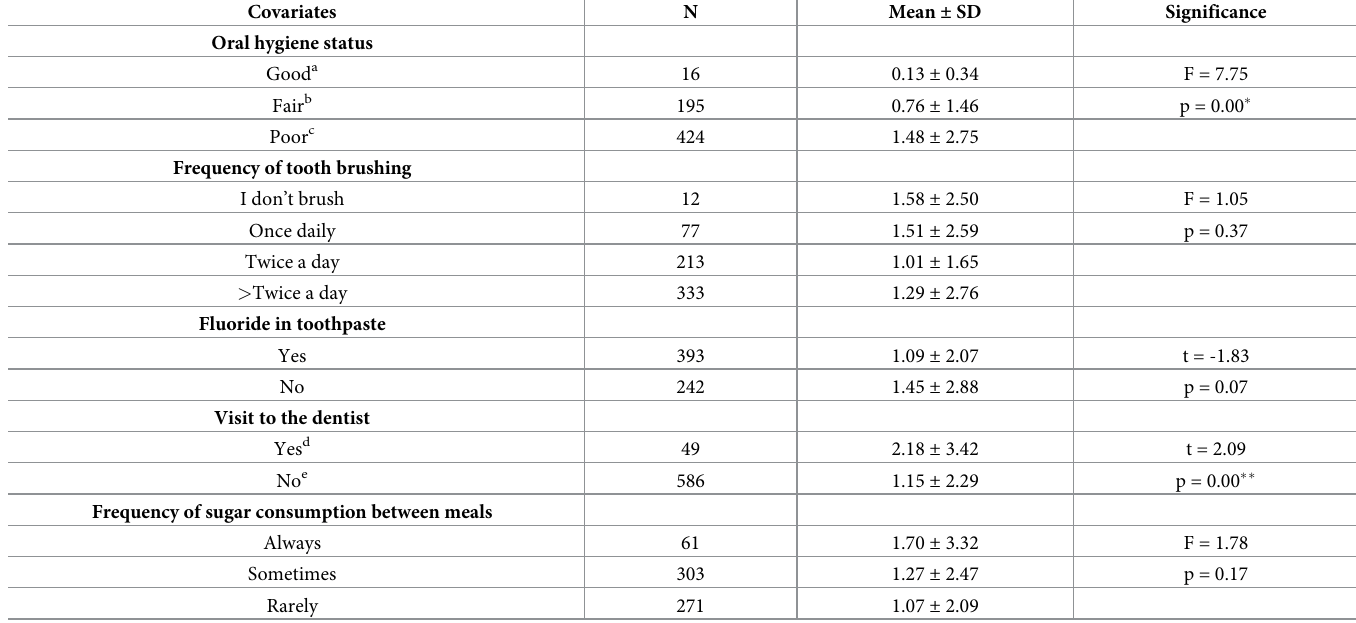
Table 4. Mean DMFT scores by oral hygiene status and practices/behaviors.